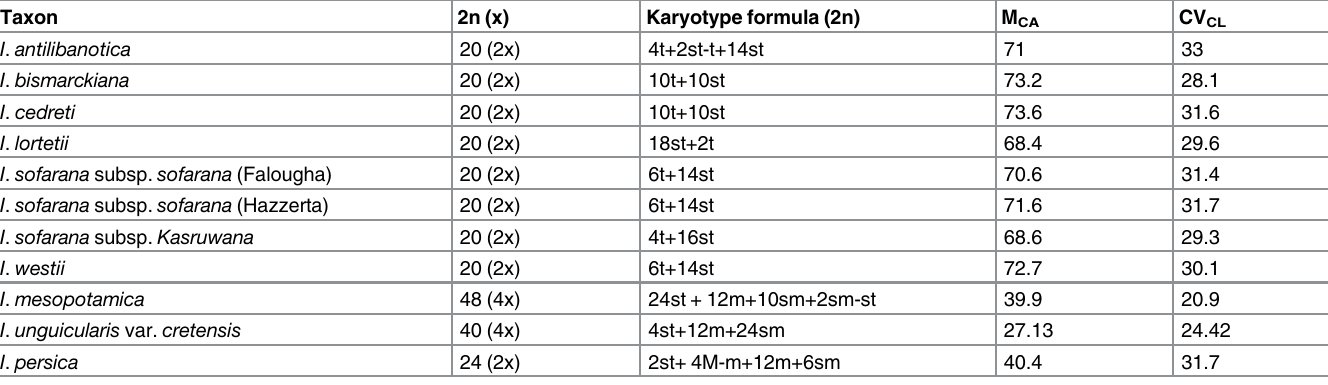
Table 2. Main data on karyotype features of investigated Iris taxa. Taxon